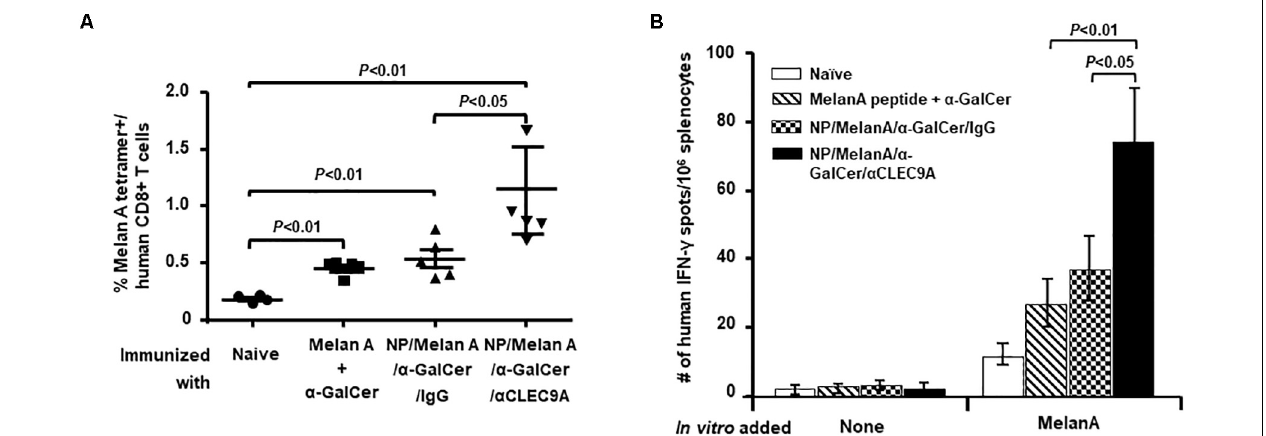
FIGURE 2 | Level of Melan-A-specific, HLA-A2-restricted human CD8 + T-cell response induced by the NP vaccines. (A) The percentage of Melan-A-specific T cells among total human CD8 + T cells in the spleen of all groups of mice was determined by flow cytometry using the Melan A tetramer. (B) The relative number of Melan-A-specific, HLA-A2-restricted human CD8 + T cells that secrete IFN- γ among splenocytes from all groups of mice was determined by an ELISpot assay. Results are displayed as the mean value and standard error ( n = 5). Statistical analyses were performed using ANOVA followed by Dunnett’s test and differences were considered if P < 0.05.